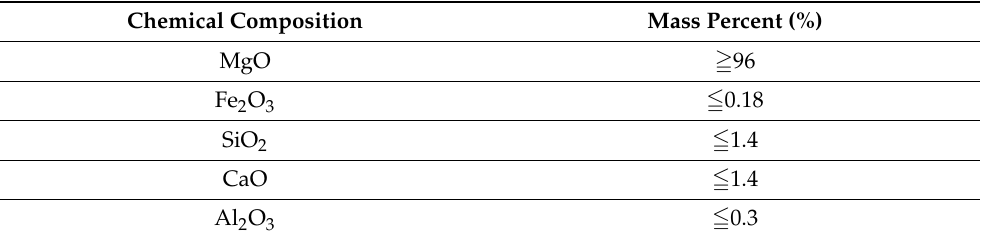
Table 1. Chemical composition of dead burned magnesia.